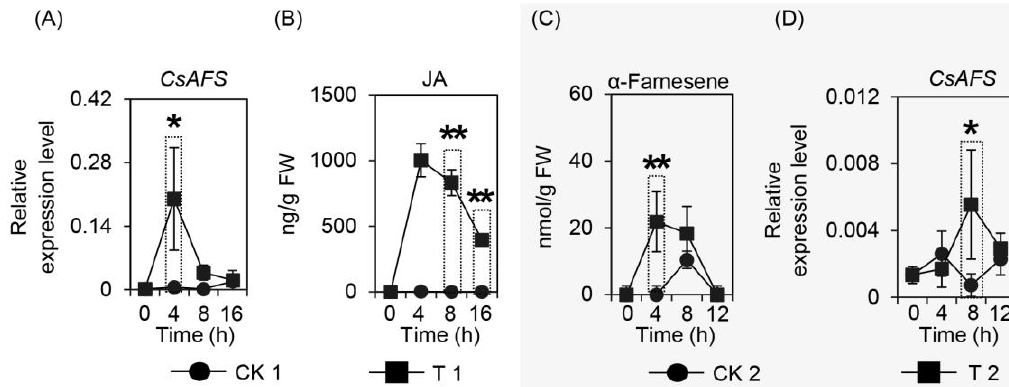
Figure 5. Changes in expression level of CsAFS , and contents of JA and α -farnesene under wounding stress and JA treatment, respectively. Variety of expression level of CsAFS ( A ) and JA content ( B ) after wounding stress. CK 1, without continuous wounding stress collected in different treatment time. T 1, with continuous wounding stress collected in different treatment time. Variety of α -farnesene content ( C ) and expression level of CsAFS ( D ) after JA treatment. CK 2, H 2 O containing 0.5% alcohol treatment collected in different treatment time. T 2, JA containing 0.5% alcohol treatment collected in different treatment time. Significant differences between control and treatment at the same different treatment time are indicated (* p ≤ 0.05, and ** p ≤ 0.01) . JA, jasmonic acid; AFS , α -farnesene synthase ; FW, fresh weight.